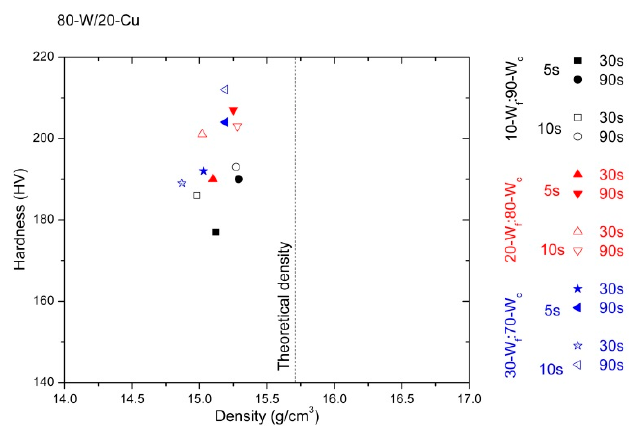
Figure 8. Hardness vs. density of 80-W/20-Cu alloy prepared from three different starting powder mixes and produced under different processing times: degasification times of 5 s and 10 s, in addition to consolidation times of 30 s and 90 s.